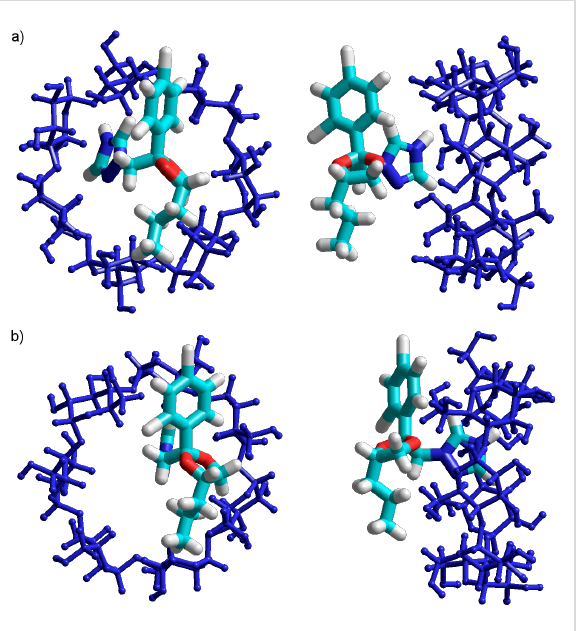
Figure 9: AM1 optimized molecular geometry of the inclusion com- pounds β -CD/PPH + in the (a) A and (b) B configurations.